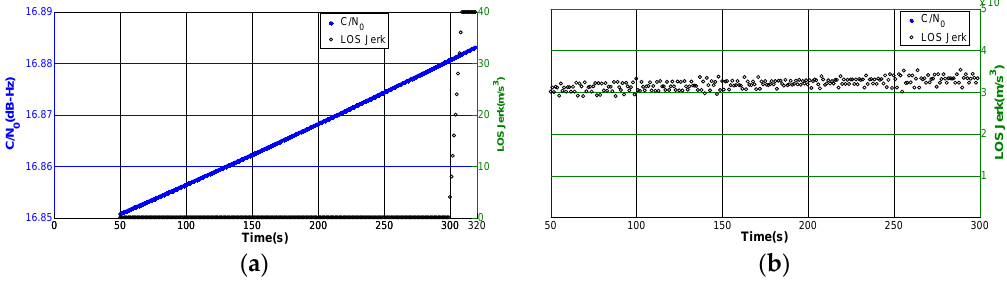
Figure 6. The variation of C/N 0 and LOS jerk for the established scenario. ( a ) Global view; and ( b ) close-up view of the second phase.